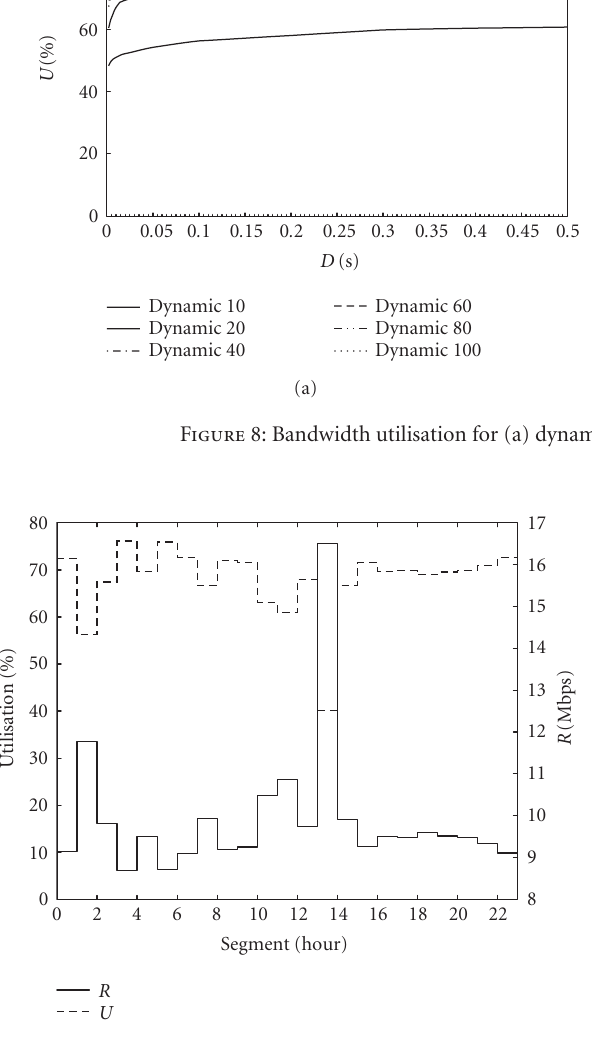
ones—it needs a coarse description of the network tra ffi c and the provisioning is done using a shaped